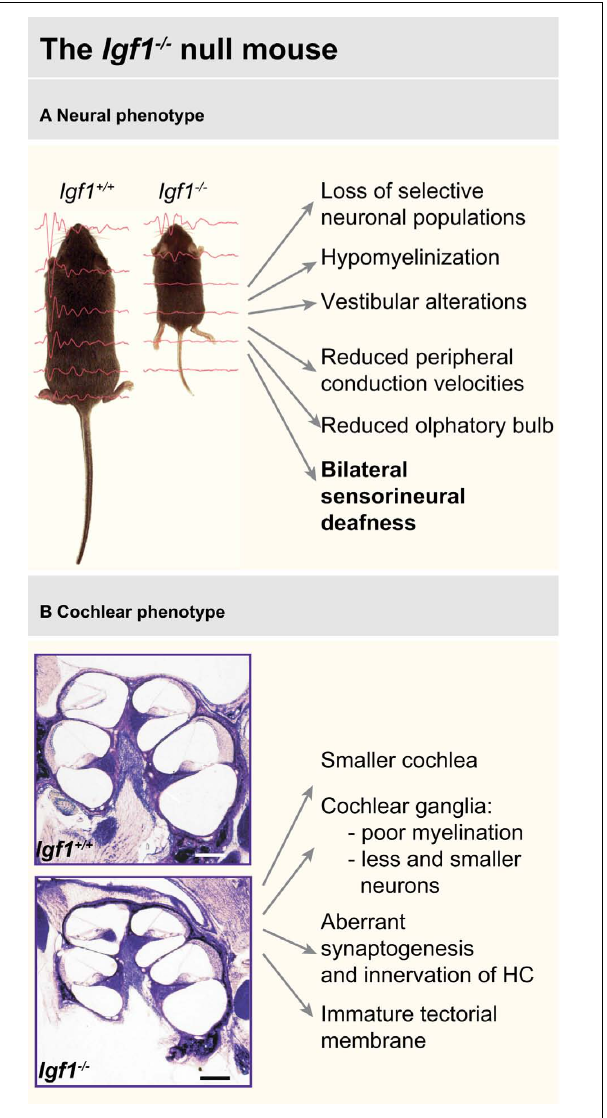
FIGURE 3 | Main features of the neural (A) and cochlear (B) phenotype of the Igf1 − / − null mouse. Data have been compiled from Liu et al. (1993), Beck et al. (1995), Cheng et al. (1998), Gao et al. (1999), Camarero et al. (2001, 2002),Ye et al. (2002a,b), Cediel et al. (2006), Sullivan et al. (2008), Riquelme et al.